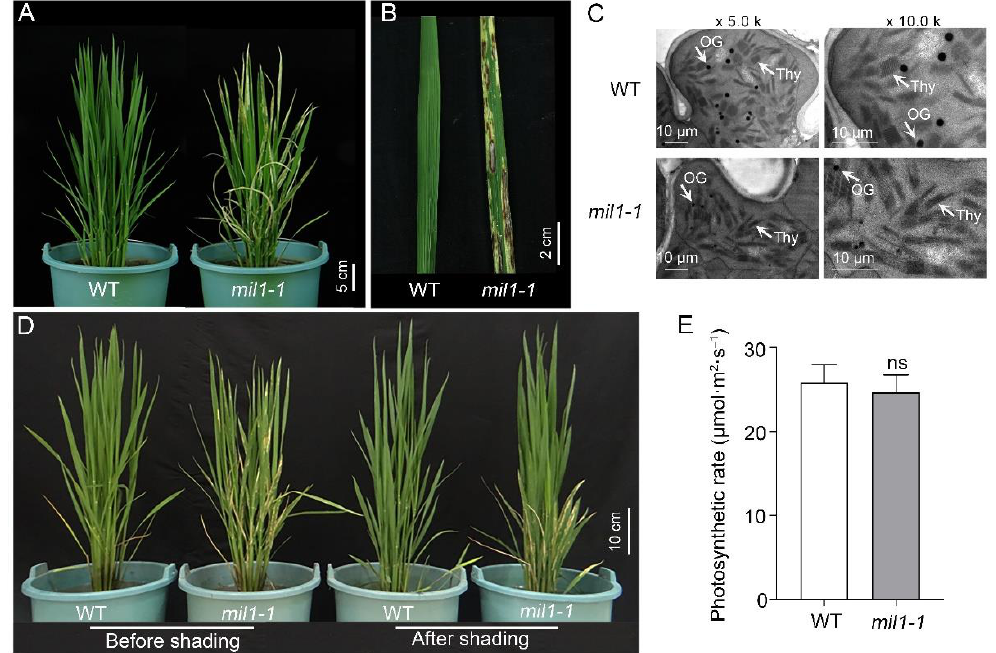
Figure 1. The mil1-1 mutation confers lesion mimic leaf phenotype in rice. ( A ) Photos of WT and mil1-1 plants at tillering stage, showing the spotted leaves of mil1-1 . Scale bar is 20 cm. ( B ) Lesion mimic leaf of mil1-1 compared to WT. Scale bar is 2 cm. ( C ) Transmission electron microscopy observation of chloroplasts in WT and mil1-1 leaves. OG: osmiophilic plastoglobuli; Thy: Thylakoid lamellae. Scale bar is 10 μm . The left and right columns are different magnifications as indicated. ( D ) Effects of shading on lesion formation of WT and mil1-1 leaves. Scale bar is 10 cm. ( E ) The photosynthetic rate of WT and mil1-1 . Data in E are mean ± SD. A two-tailed unpaired t - test with Welch’s correction is used for statistical analysis. ns indicates no significant difference.